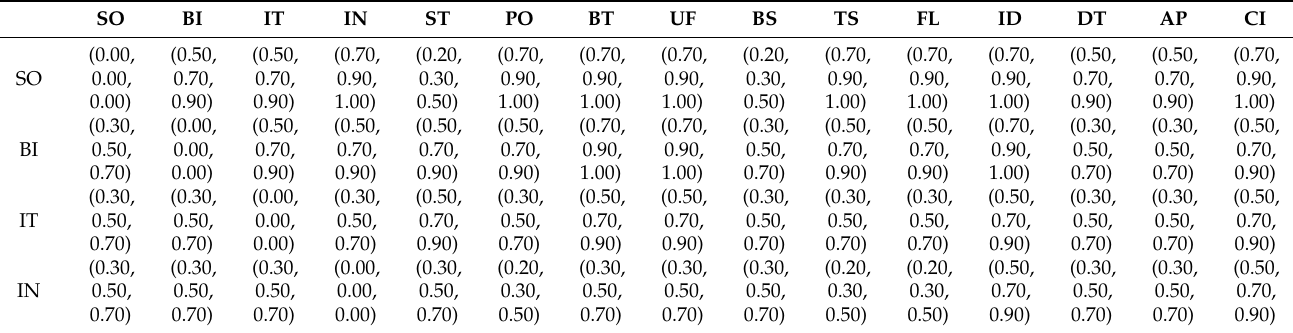
Table 8. Fuzzy direct relation